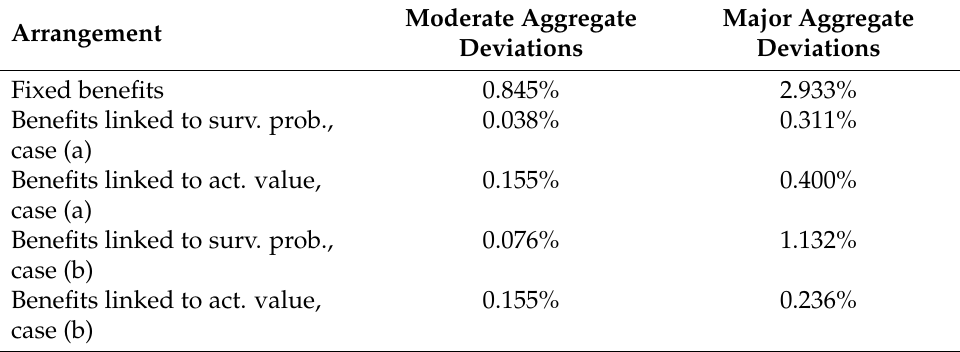
Table 4. Equivalent initial fee π (to be charged to the initial